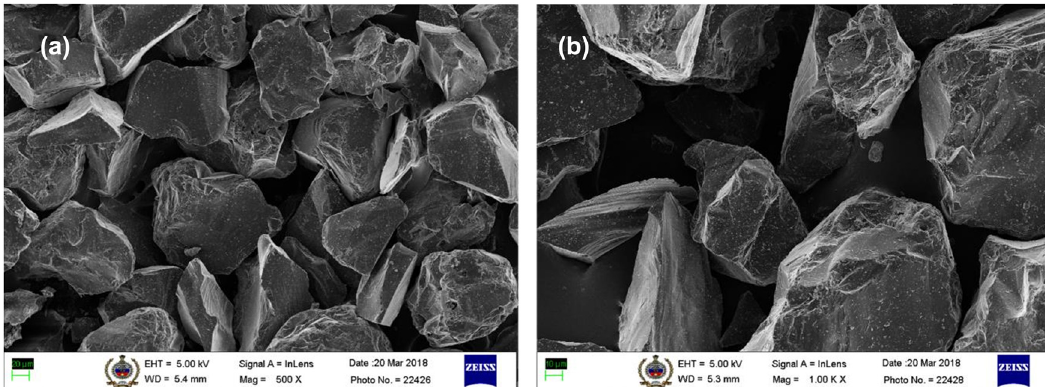
Figure 5: ( a ) and ( b ) SEM images of B 4 C particles at di ff erent magni fi cations.